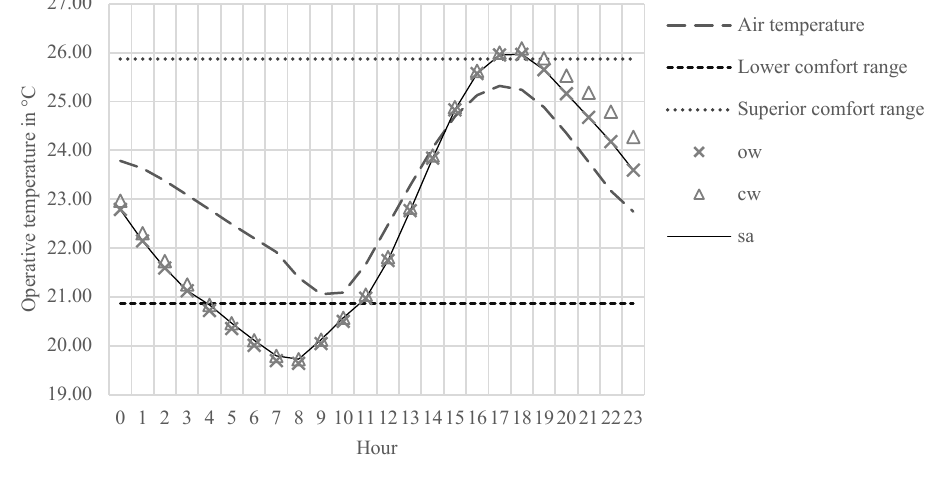
Fig. 5. Operative temperature analysis for March